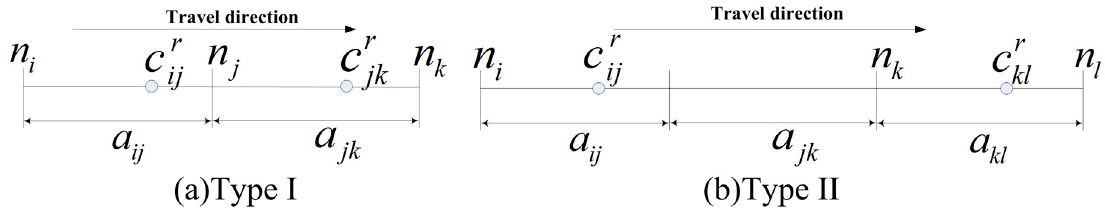
Figure 3. The locations of two consecutive sampling points of the r th probe vehicle.